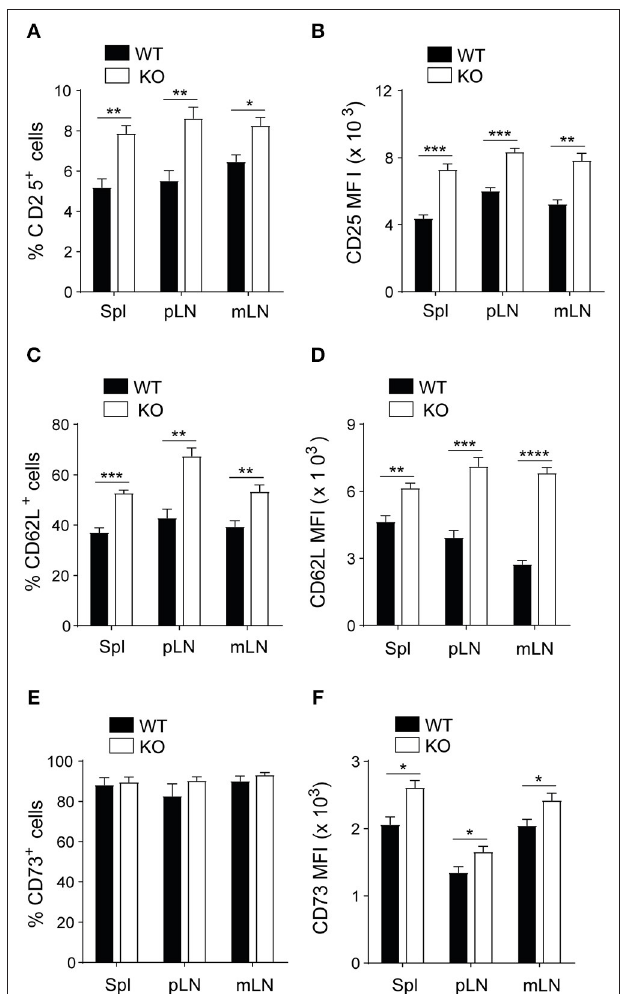
FIGURE 1 | Tregs from PAR4ko mice express higher levels of CD25, CD62L, and CD73 molecules. Cells obtained from homogenized the spleen, peripheral lymph nodes (pLN) and mesenteric lymph nodes (mLN) of C57BL/6 WT (filled bars) and PAR4ko (open bars) mice were analyzed using flow cytometry. The percentage of CD25 + cells in the CD4 + T cells (A) and within the CD4 + CD25 + T cells the percentages of CD62L and CD73 (C,E) are shown. The MFI levels for the same populations of these cells in (A,C,E) are shown in (B,D,F) . Graphs represent mean ± SEM from six mice per group. Data were analyzed by unpaired two-tailed t -test. * p < 0.05, ** p < 0.005, *** p < 0.0005, and **** p < 0.0001 when WT and PAR4ko Tregs were